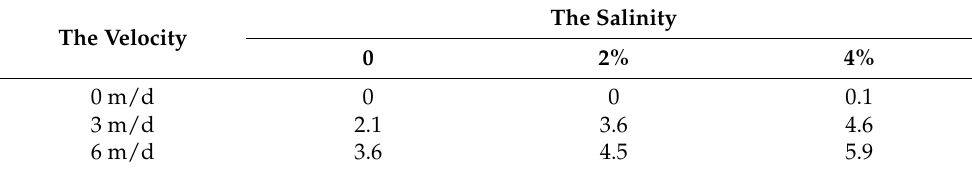
Table 4. The temperature difference between B13 and B1 under different test